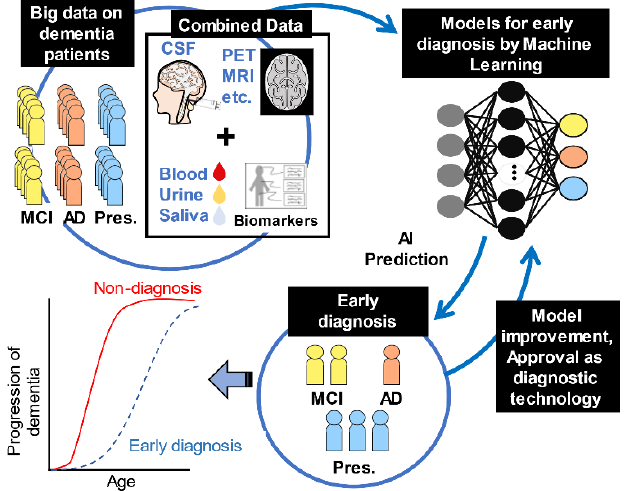
Figure 3. Extensive data search by machine learning. The first step is to collect big data from dementia patients. Then, they are labeled as presymptomatic (Pres.), mild cognitive impairment (MCI), and Alzheimer’s disease (AD) patients. Next, input to machine learning from a large amount of labeled data. The results of this machine learning are evaluated to calculate a model that can make accurate predictions. The next stage is the implementation phase. New unlabeled invasive data, PET (positron emission tomography), and MRI (magnetic resonance imaging) data are used to train machine learning models and make predictions. The output is the result of predicting whether the patient is Pres., MCI, or AD. These results can be used for the early diagnosis of AD. Furthermore, to develop accurate early diagnosis techniques, it is crucial to improve machine-learning models with feedback from diagnostic